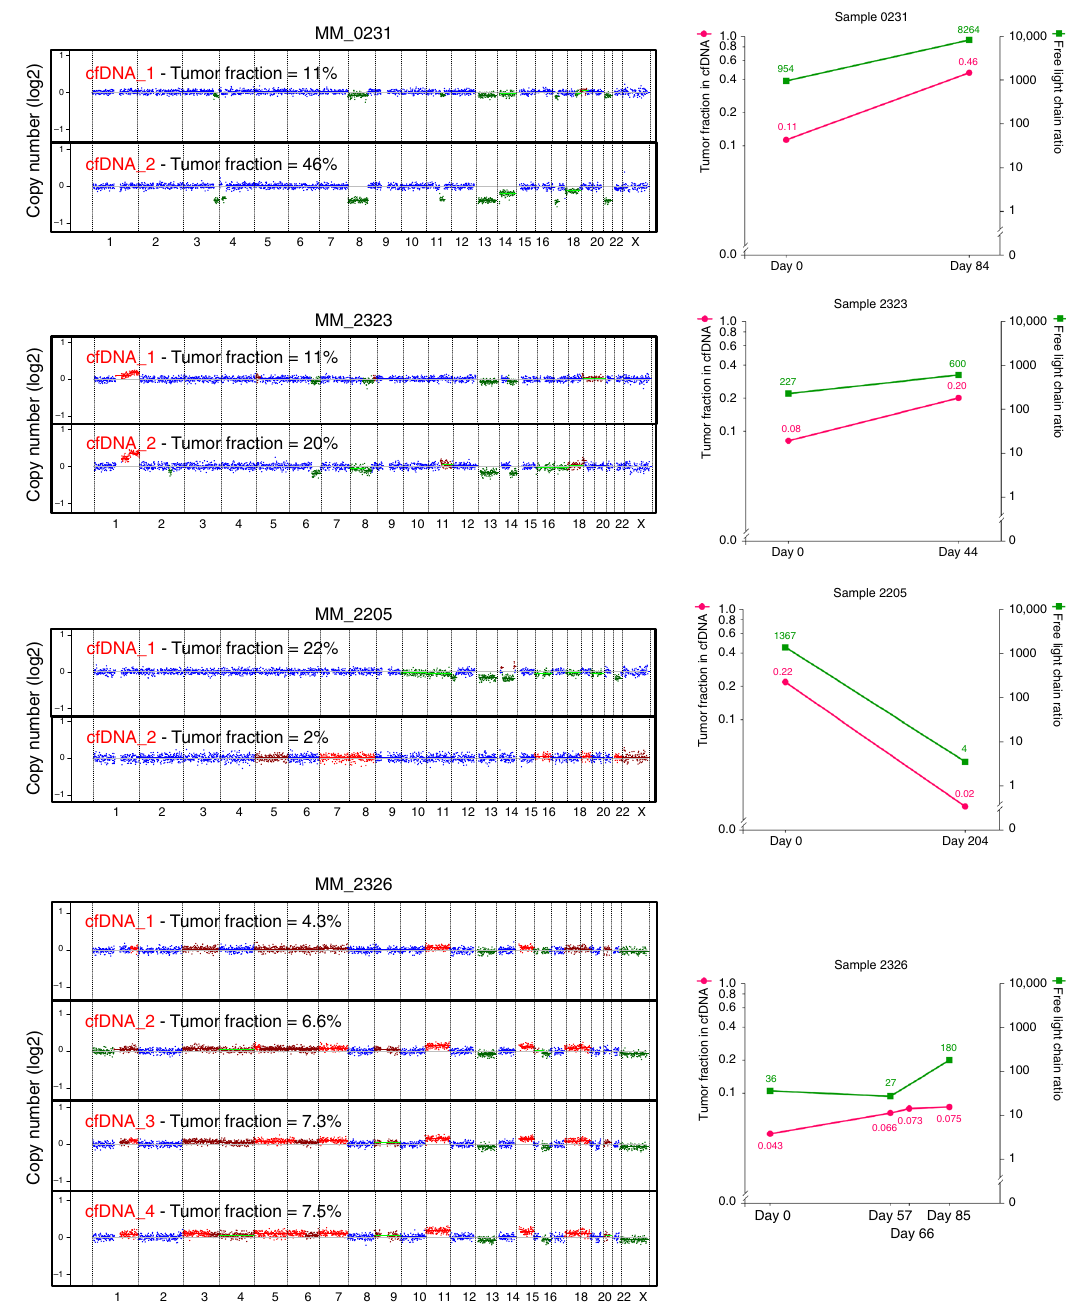
Fig. 3 Monitoring progression or response to therapy with liquid biopsy. Comparison of copy ratios between cfDNA ULP-WGS from sequential samples from same MM patients. Tumor fraction (pink) and free light chain ratio (green) for each patient are also shown in this fi gure. Ampli fi cation (red), deletion (green), and copy neutral (blue) are